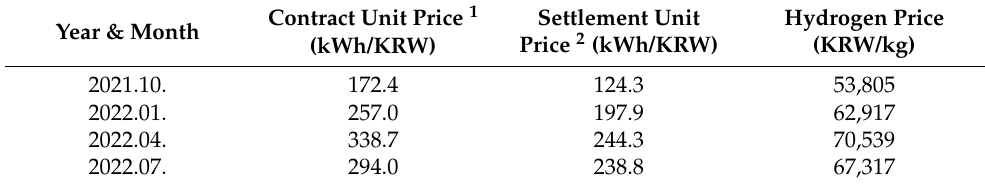
Figure 10. The trend of the settlement unit price for renewable energy for a recent year * [17]. * x -axis: Year/Month, y -axis: Settlement Unit Price (KRW/kWh). Table 28. Estimation of hydrogen cost applying electricity price in the previous period. Contract Unit Price 1 Year & Month